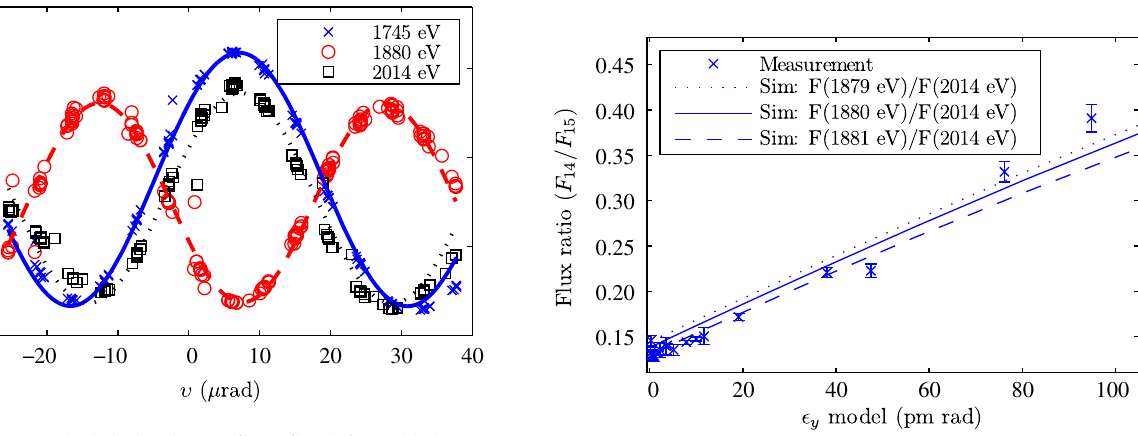
FIG. 7. Measurement of undulator radiation flux ratios using orbit bumps through a vertical undulator at the AS storage ring, for various vertical emittances ϵ y . Simulations are plotted with uncertainty in the photon energy